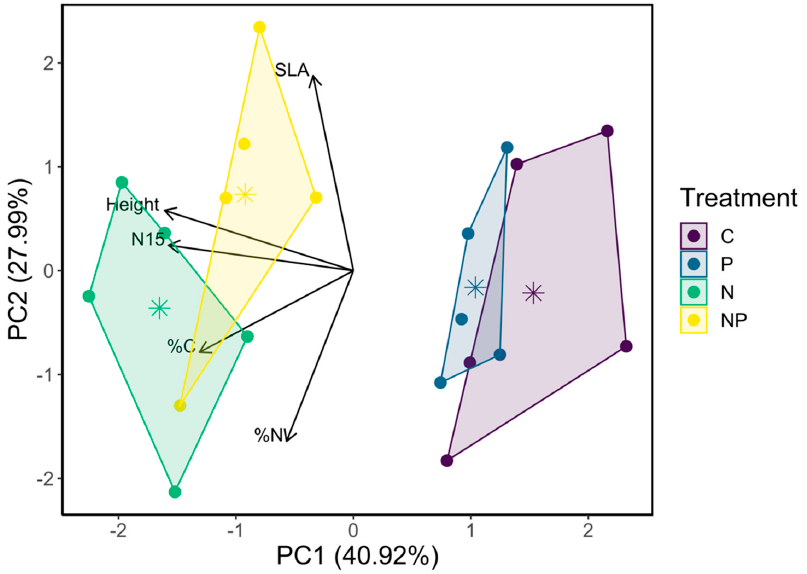
Figure 3. Principal components analysis (PCA) of trait-based community composition grouped in convex hulls by nutrient treatment type on a barrier island grassland community. Points represent individual experimental plots in functional trait space with asterisks indicating centroids for each group. Colors and symbols are matched to nutrient treatment (C = control, P = phosphorus, N = nitrogen, and NP = nitrogen + phosphorus). Centroids can be viewed as mean trait-based community composition. Vectors indicate functional trait correlations with each axis. Vectors are labeled with the functional trait they represent, and lengths indicate goodness of fit (Table S1). Table 1. Pairwise comparisons via PERMANOVA results for trait-based communities between nutrient enrichment treatments on coastal grassland. Bold indicates p < 0.05, using FDR correction.